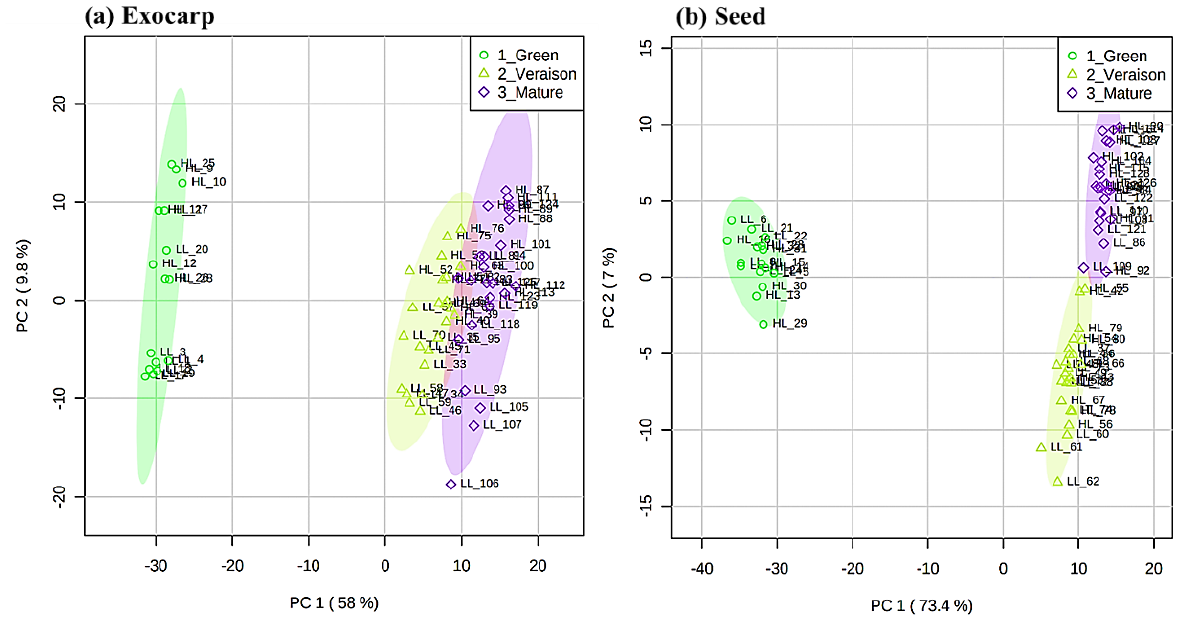
Figure 1. Principal component analysis (PCA) score plots of the liquid chromatography mass spectrometry (LCMS) metabolite data for the exocarp ( a ) and seed ( b ) in berries at three developmental stages (green, véraison , mature), including both microclimates (high light (HL) and low light (LL)) and both mitigation treatments. Colored ellipses represent 95% confidence interval ( n = 4 for green stage and n = 3 for véraison and mature stages).